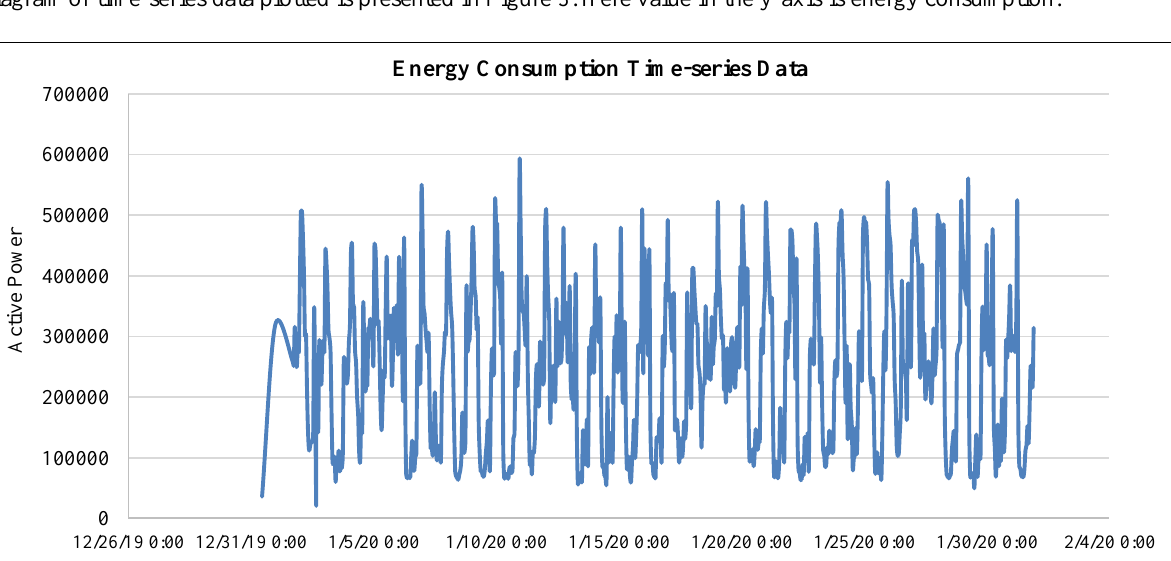
Figure 3. One Month Energy Consumption Time-series Data